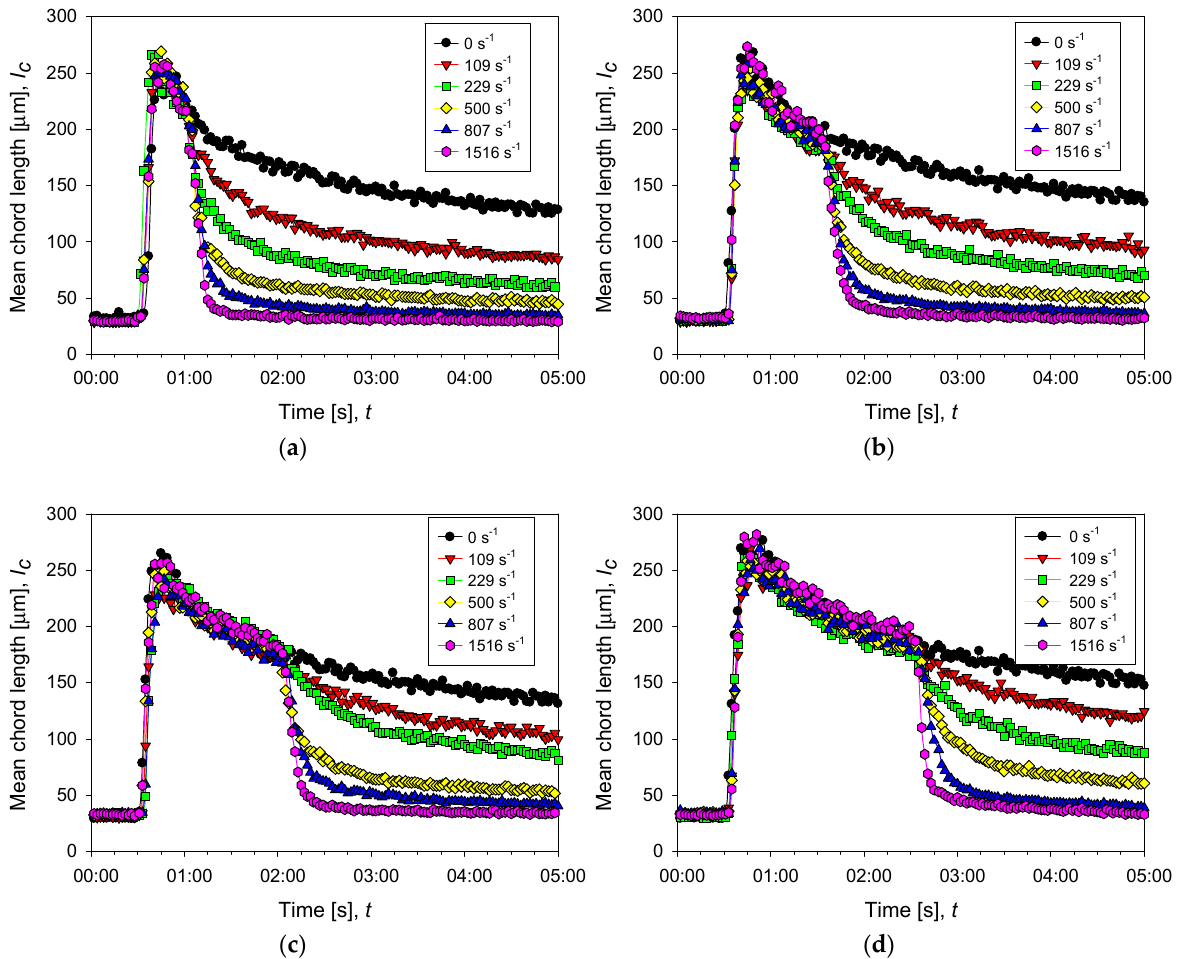
Figure 6. Evolution of the average size of aggregates of kaolin in suspensions with different doses of flocculant in SW and IW at a shear rate of 200 rpm (black dots) and after several increments of shear rate (color dots). The curves with increased shear show three stages, pre-flocculation (primary particles remain free), flocculation (particle size first increases sharply by aggregation and then decreases smoothly with time), and disaggregation (particle size decreases abruptly as shear is increased). ( a – c ) correspond to 13, 34, and 89 g/t of flocculant in seawater, respectively, while ( d ) corresponds to 89 g/t of flocculant in industrial water.